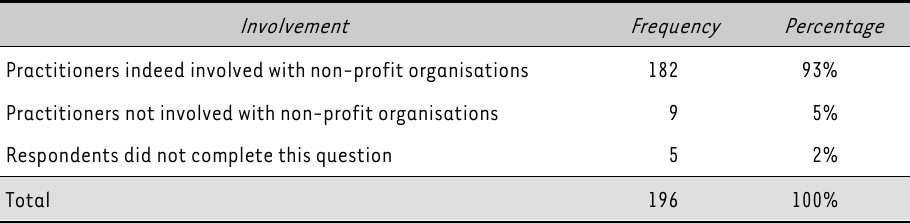
Respondents' involvement in the financial reporting of non-profit organisations Involvement Frequency Percentage